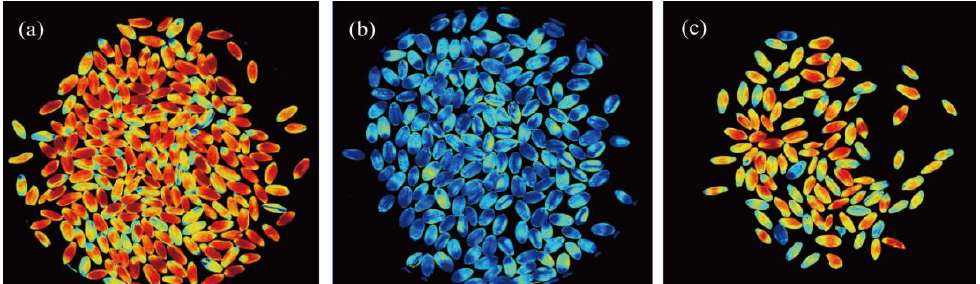
Figure 4. Images generated using nCDA algorithm for: ( a ) 100% T. durum wheat grains; ( b ) 100% T. aestivum wheat grains; ( c ) 10% adulteration of T. durum wheat grains with T. aestivum wheat grains [99].